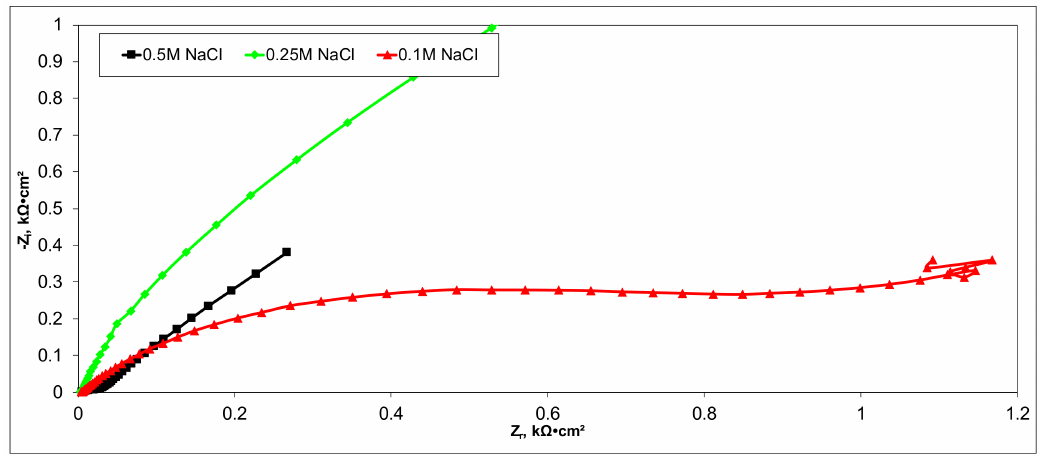
Figure 17. Nyquist (zoom) plots for the X4 variant in NaCl: 0.5M, 0.25M, 0.1M.